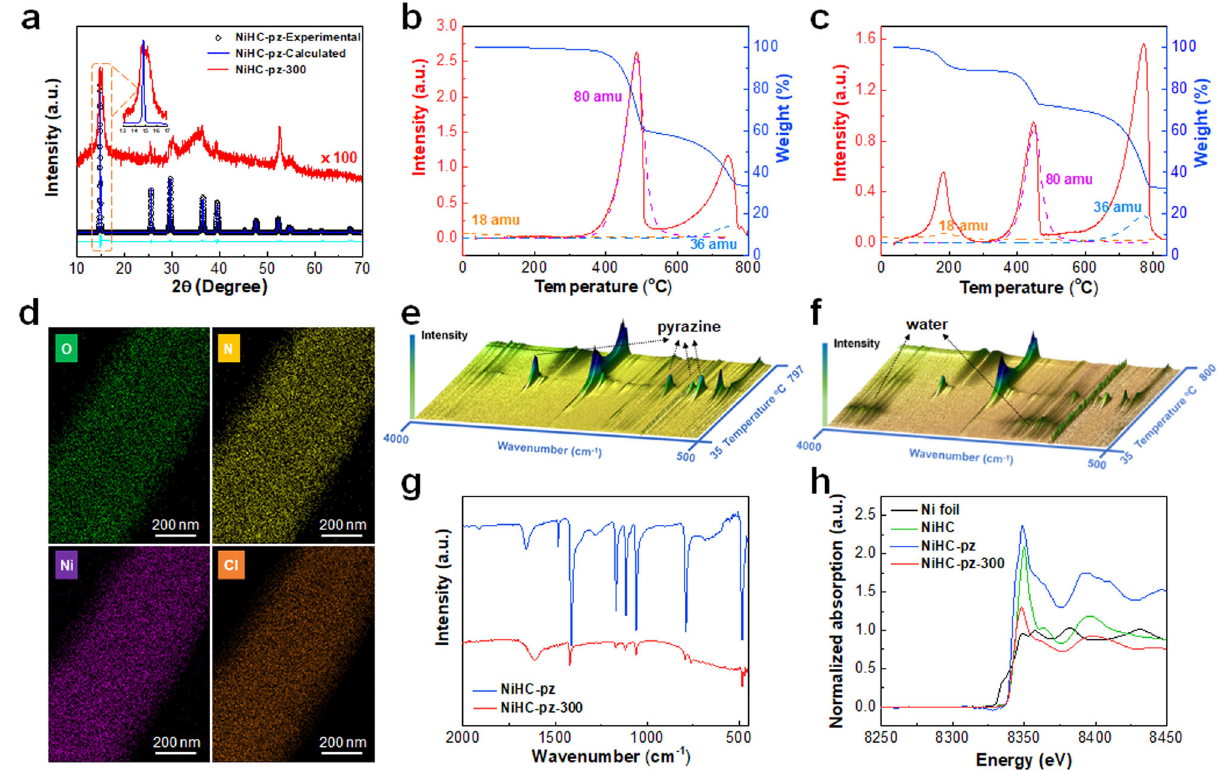
e TGspectrumandMScountingoftheNiHC-pz-300. f FTIRspectraoftheNiHC-pz. g FTIR spectraof the NiHC-pz-300 for the TG-FTIR-GCMS analysis. h EDX mapping of the